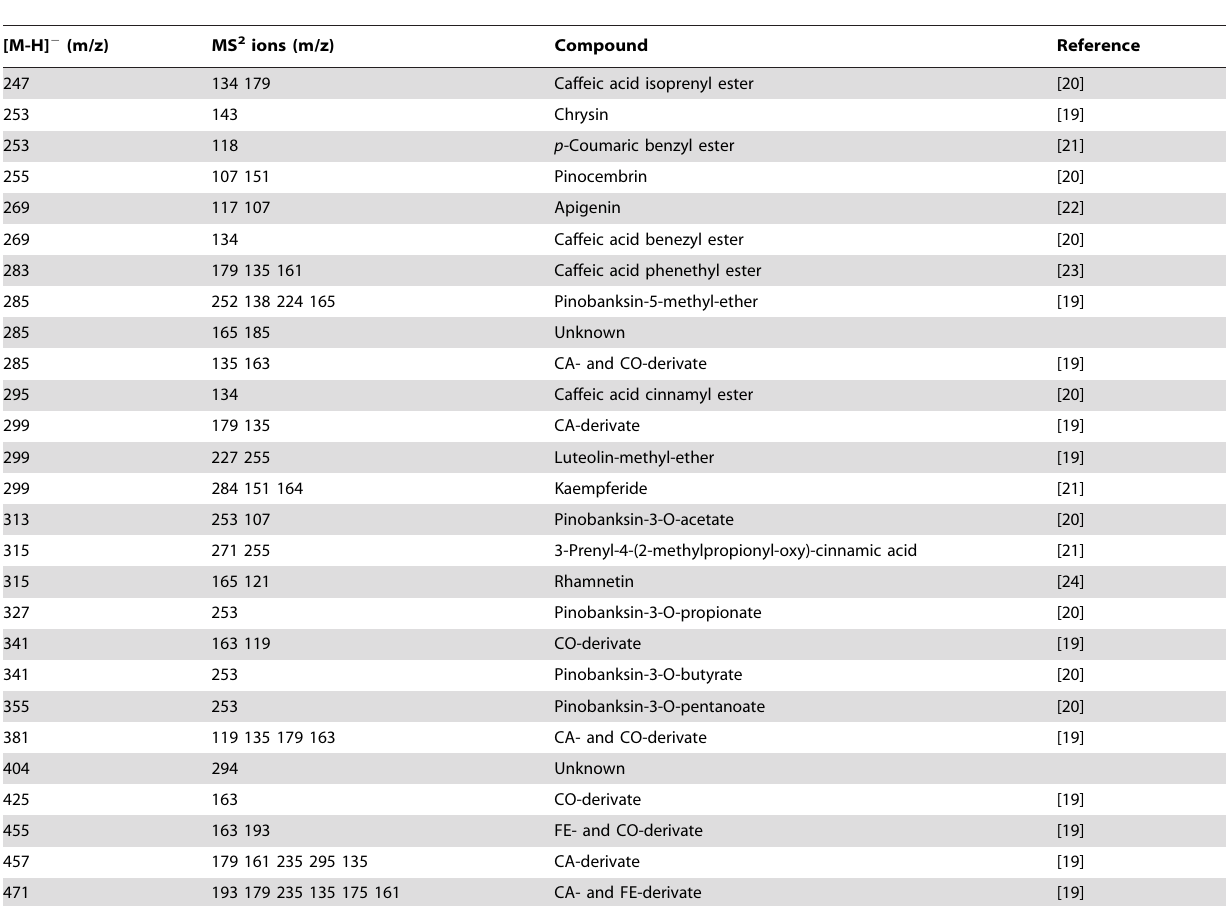
Table 2. Phenolic compounds identified in eluate EL70 using mass spectrometry